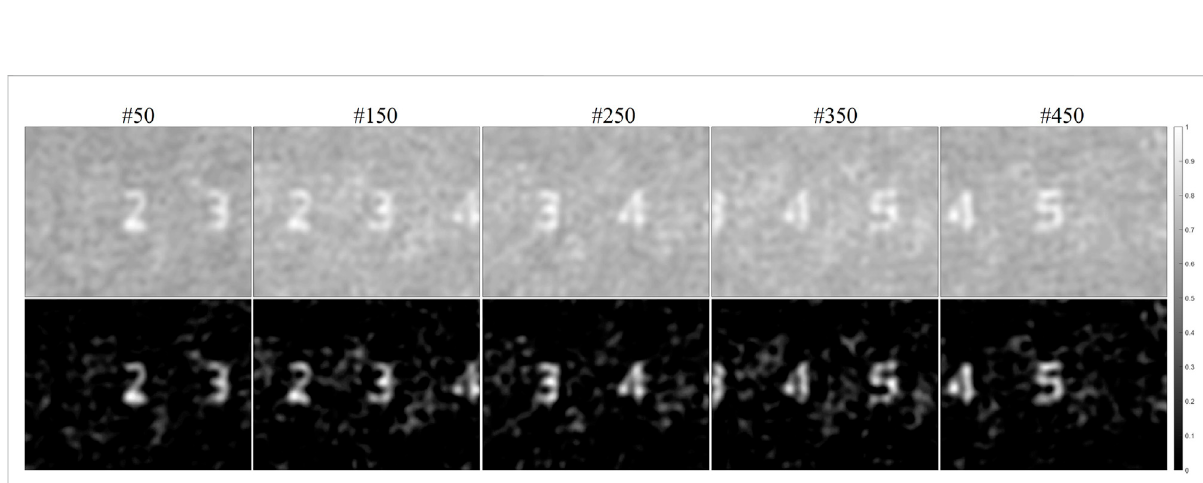
FIGURE 4 Imagesofamovingobject.The fi rstrowexhibits fi veframes(the50th,150th,250th,350th,and450th)ofthevideodirectlycapturedbytheCCD at an exposure time of 1 ms . The second row are the images after applying simple background removal on the aforementioned images (refer Eq.